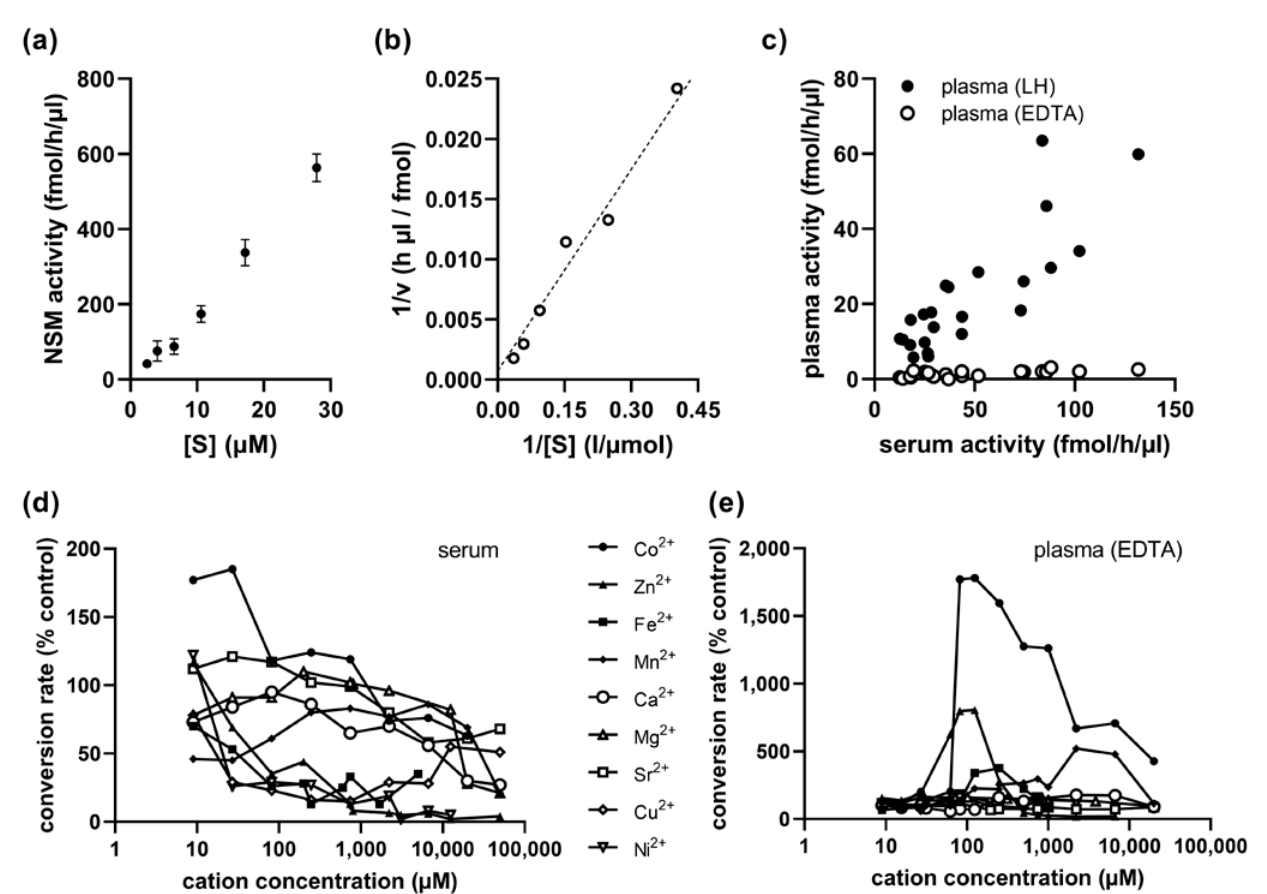
Figure 2. Kinetics and optimization of reaction conditions for EDTA-anticoagulated plasma samples. ( a ) Substrate–velocity graph for serum NSM activity. ( b ) Lineweaver–Burk plot with nonlinear regression line. ( c ) Correlation between NSM activities in serum and lithium heparin (LH) anticoagulated plasma versus nearly undetectable NSM activities in EDTA-anticoagulated plasma. ( d ) Mostly inhibitory influence of different divalent cations on NSM activity in serum samples. ( e ) Influence of cations on NSM activity in EDTA-anticoagulated plasma samples with the highest benefit from addition of cobalt ions.